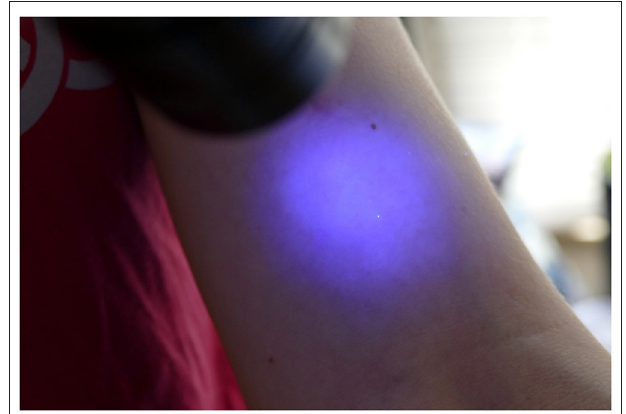
FIGURE 2 | Small spot (1 × 1mm) of contamination.